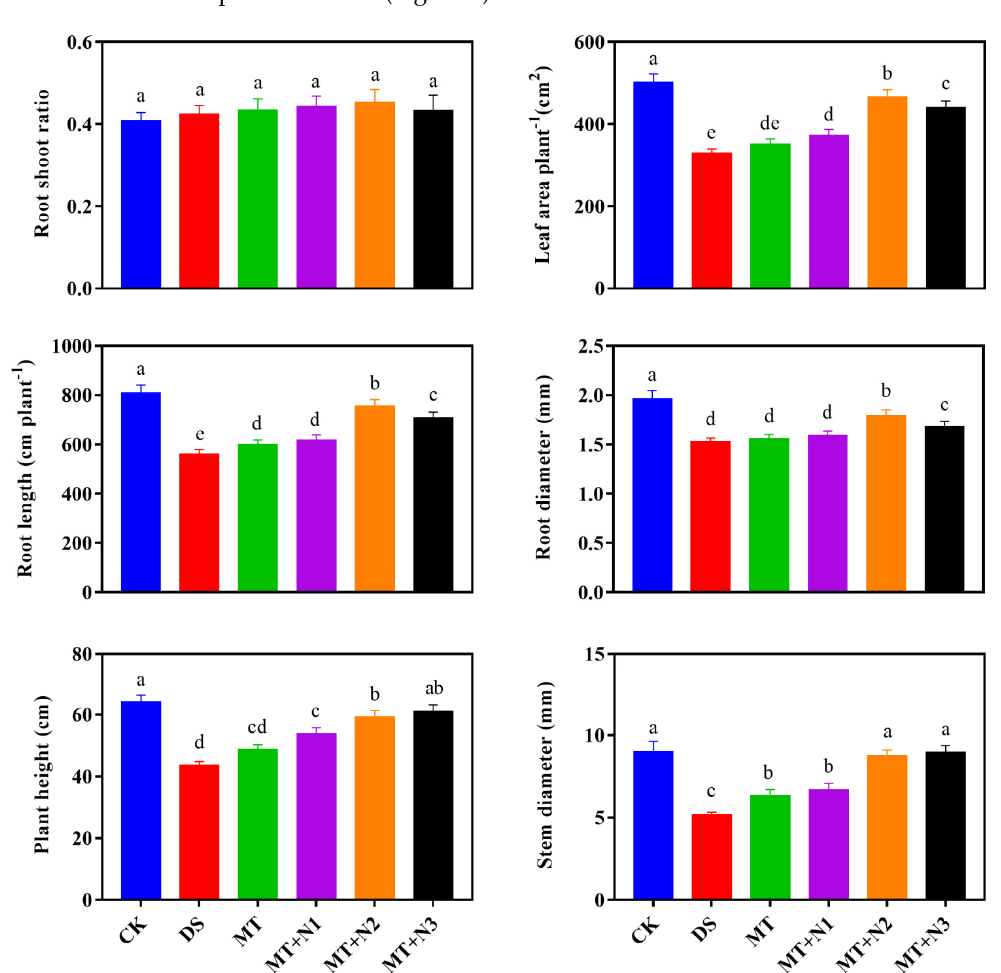
Figure 2. Root to shoot ratio, leaf area, root length and diameter, plant height, and stem diameter of maize seedlings under drought-stress conditions in combination with melatonin in different levels of nitrogen. CK; Well-watered control without melatonin (MT), DS; Drought stress without MT, MT; Drought stress + 100 µ M MT, MT + N1; MT 100 µ M + 200 kg N ha − 1 , MT + N2; MT-100 µ M + 250 kg N ha − 1 , and MT + N3; MT-100 µ M + 300 kg N ha − 1 . Vertical bars represent ± S.D. ( n = 3, biological replicates). Different letters indicate significant differences as determined by the LSD test ( p ≤